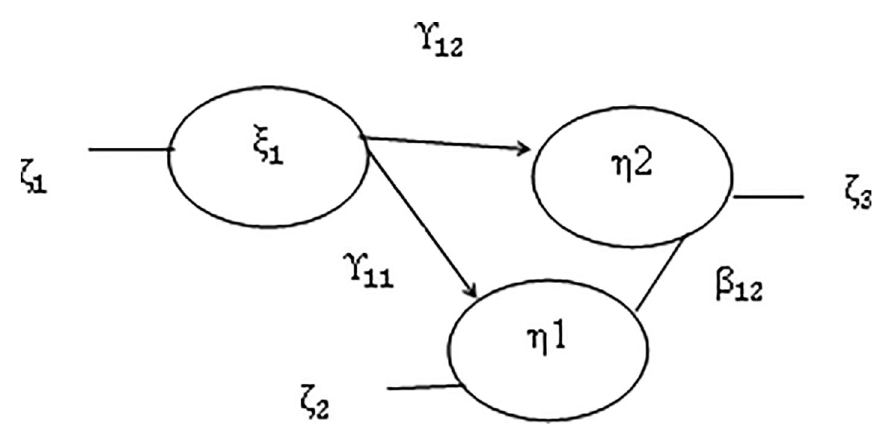
Figure 1. Structural model of the relationship between variables (Sugiyono, 2017). Description: ξ _1 = latent variable effectiveness of leadership behavior patterns η 1 = latent variable of teacher performance η 2 = latent variable of student achievement γ _12 = coefficient of direct influence of variable effectiveness of leadership behavior patterns on student achievement. γ _11 = coefficient of direct influence of variable effectiveness of leadership behavior patterns on teacher performance. β _12 = coefficient of influence of teacher performance variables on student achievement variables ζ _1 = Measurement error effectiveness of leadership behavior patterns ζ _2 = Measurement error of teacher performance ζ _3 = Measurement error of student